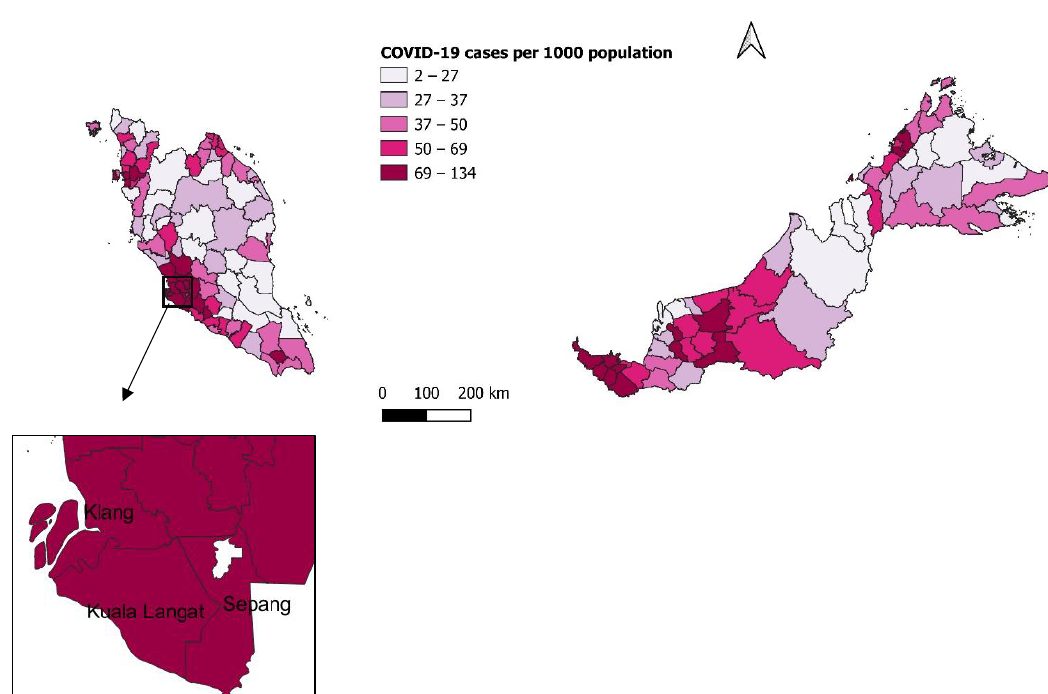
Figure 2. Distribution of COVID-19 incidence by district, 20 September 2020 to 19 September 2021,